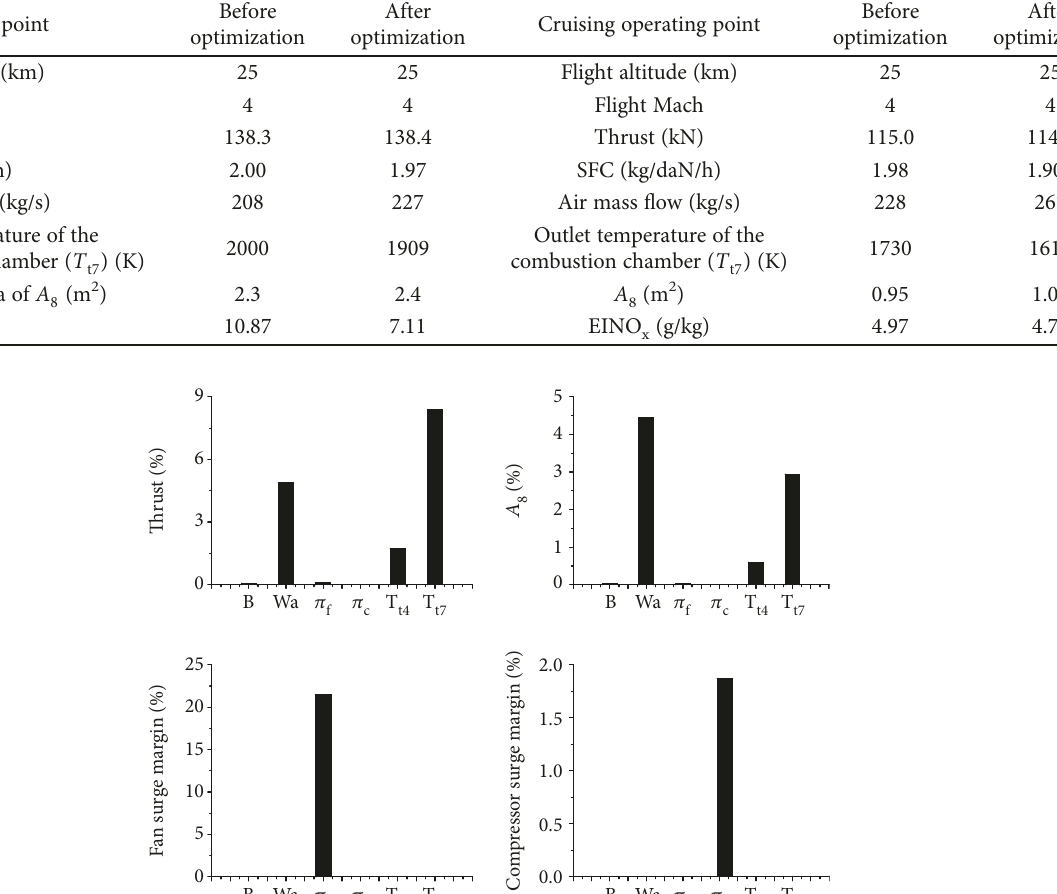
Table 7: Ramjet mode optimization scheme (design and cruising point).